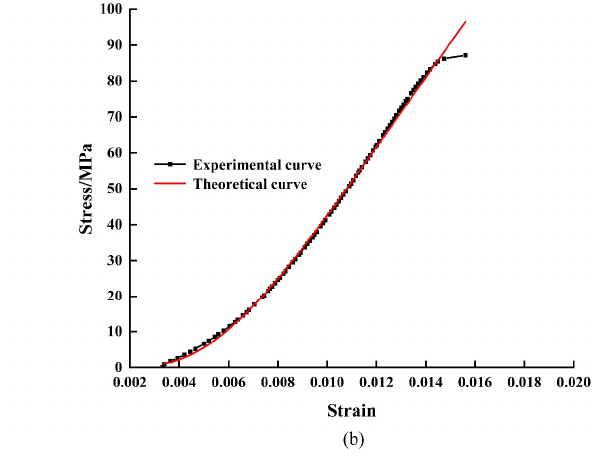
Figure 9. Curve fitting of loading section: (a) 30 MPa. (b) 90 MPa.